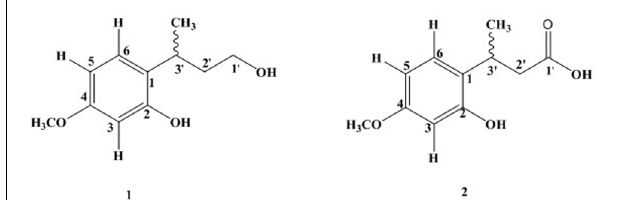
FIGURE 1 | Structure of compounds [ 1 and 2